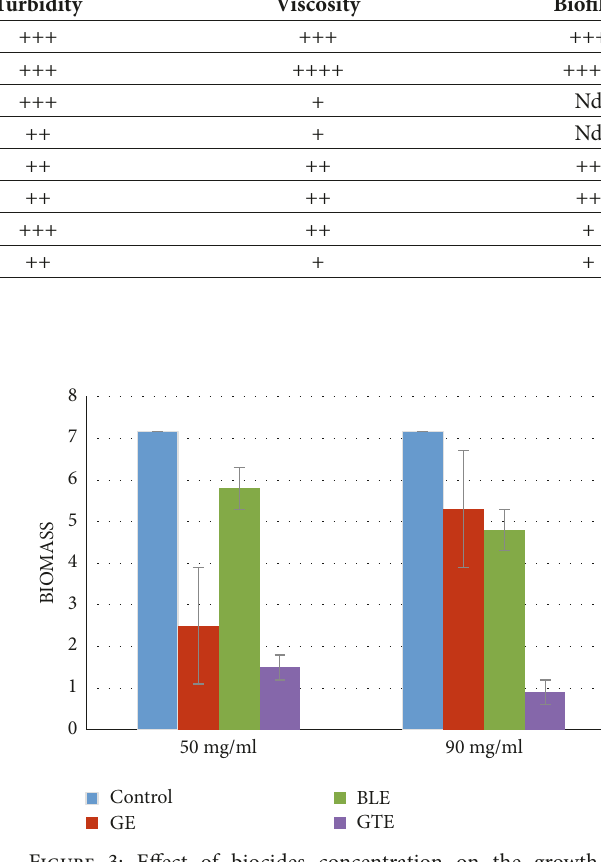
Figure 3: Effect of biocides concentration on the growth of planktonic SRB in 100 mL vials at 37 ∘ C in anaerobic condition. The biomass concentration was evaluated at the day 6 th